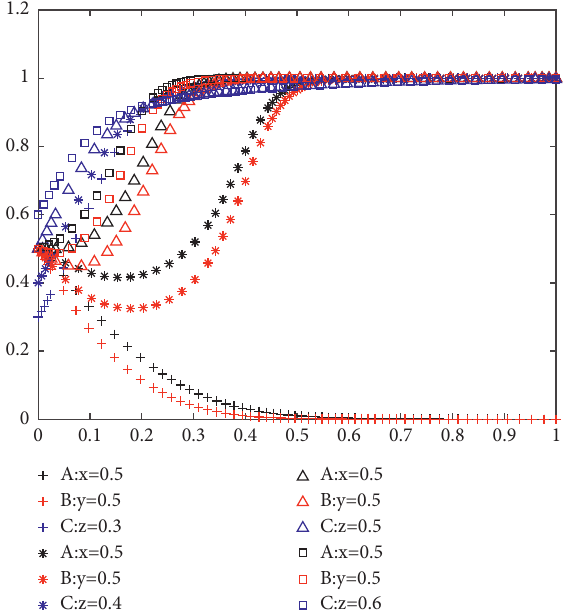
Figure 3: Evolutionary analysis of changes in initial willingness to participate in cooperation (z).